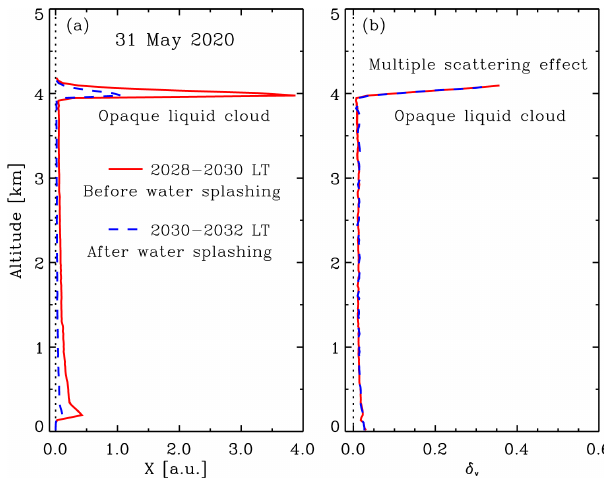
Figure 1. Comparison of the lidar profiles with (integrated from 20:30 to 20:32LT on 31 May 2020, dashed blue line) and without (integrated from 20:28 to 20:30LT on the same day, solid red line) water accumulation on the lidar roof windows. (a) Range-corrected 355nm signal X profiles; (b) 355nm volume depolarization ratio δ v profiles. The water accumulation was produced by an artificial water-splashing experiment.